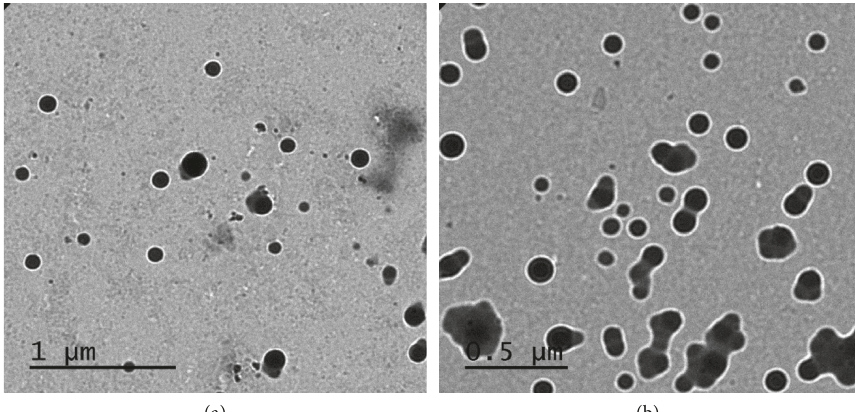
Figure 4: Transmission electron micrographs of PLGA-NAC nanoparticles.